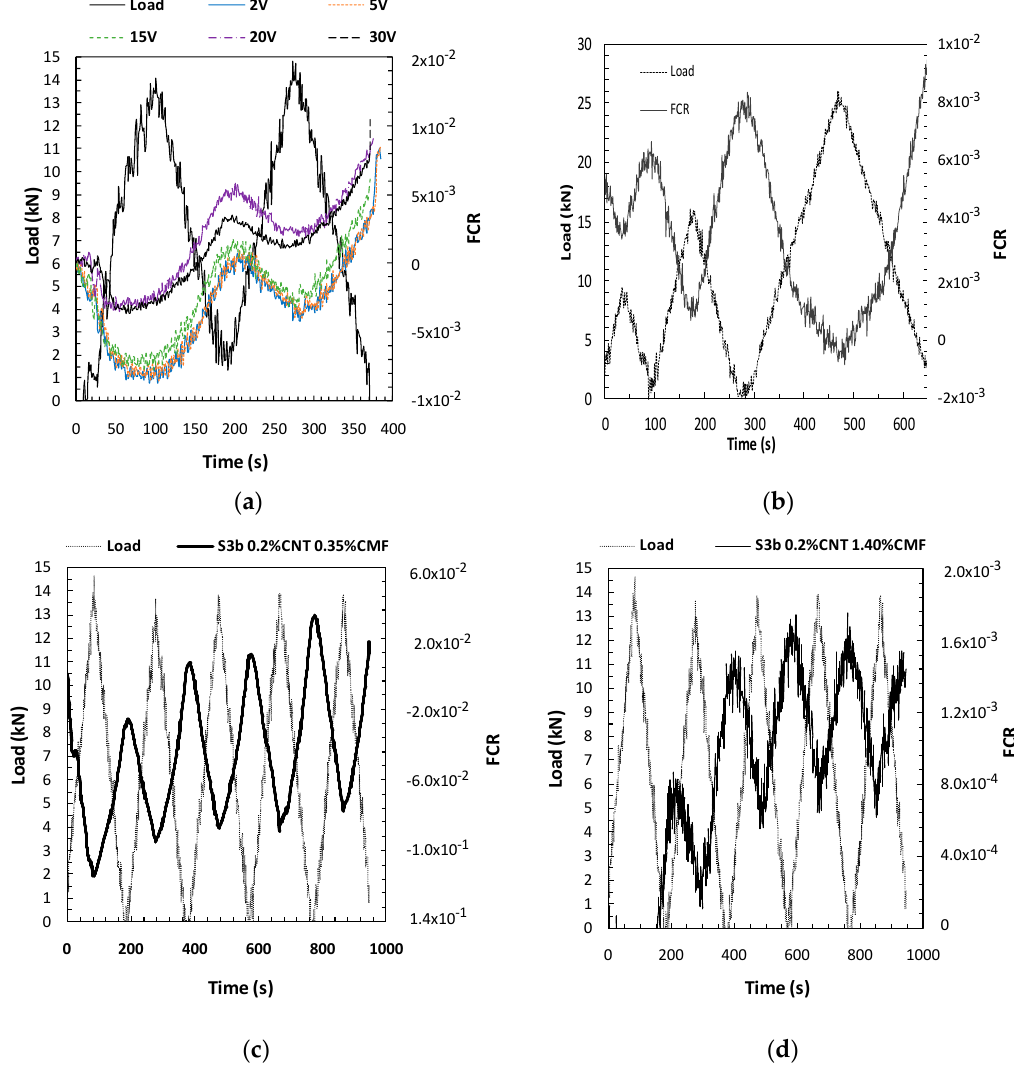
Figure 8. Compression load cycles versusfractional change of electrical resistivity (FCR) for SCC with CNT+CMF. Voltage ( a ), load level ( b ),additive content, 0.2%CNT+0.35%CNT ( c ), and 0.2%CNT+1.4% CMF ( d ).